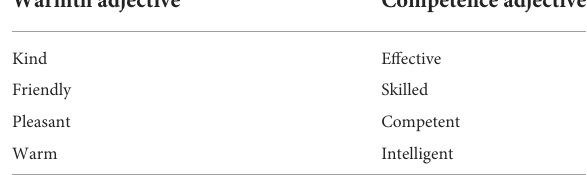
TABLE 2 Questions to the participants to measure their perception of the agent and of the user. Measure